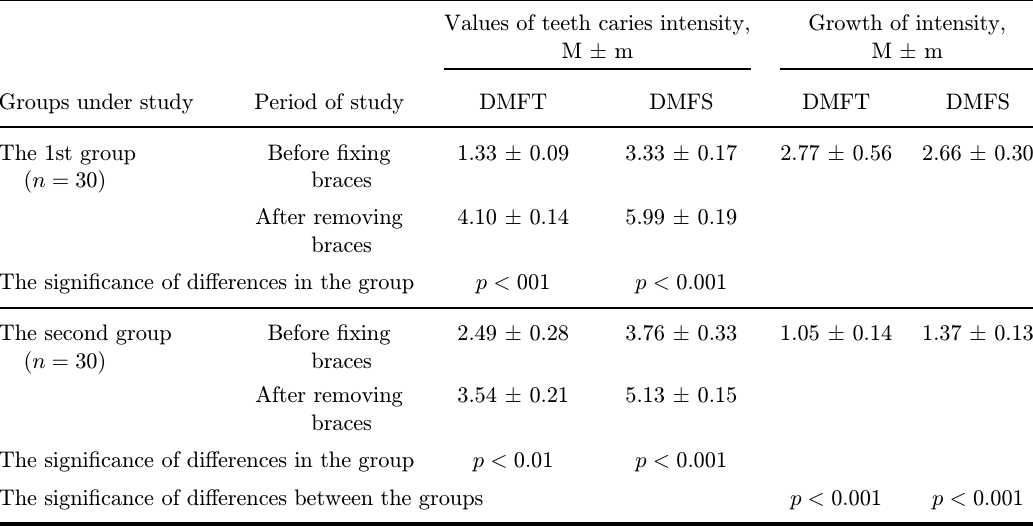
Table 5. Comparative values of DMFT and DMFS indices and growth of those indices in both groups before and after orthodontic